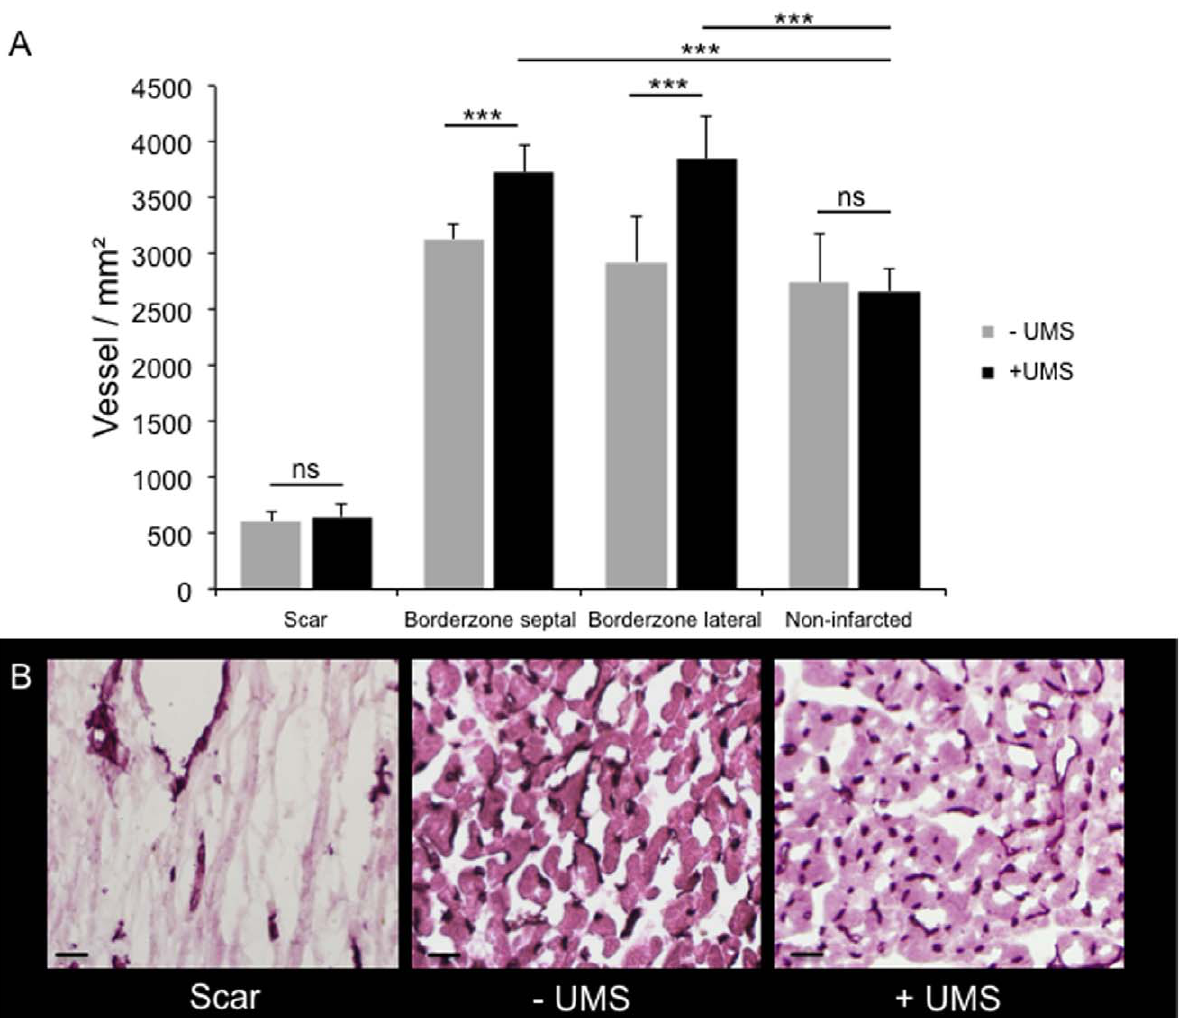
Figure 9. Microvascular density assessed by CD31 staining. (A) Microvascular density was assessed in the myocardial scar, both adjacent borderzones, and non-infarcted regions (posterior left-ventricular wall). No differences between untreated and UMS-treated animals were found with respect to the scar tissue and the non-infarcted regions. However, the myocardial borderzone tissue of UMS-treated mice revealed a significantly increased microvascular density as compared to non-treated animals. (B) Representative CD31 stained histological images of scar, untreated borderzone ( 2 UMS), and UMS-treated borderzone ( + UMS) (from left to right). CD31 positive vessels can be identified by their dark colour. Note the higher microvascular density of the UMS-treated mice compared to the non-treated group. In contrast, scar displayed the lowest microvascular density.